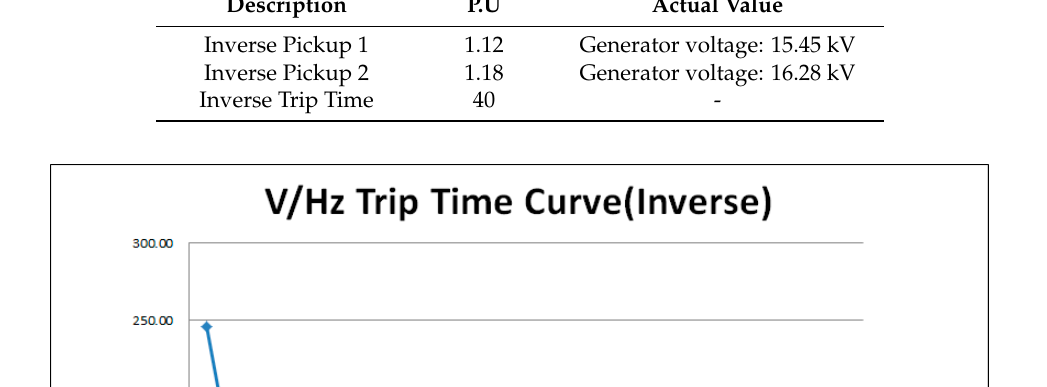
Table 5. Set values for over-excitation.